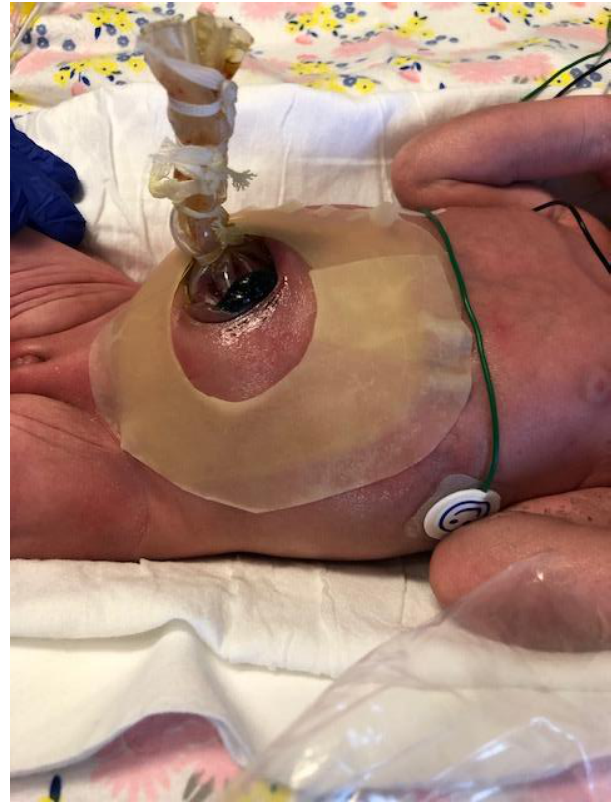
Figure 3. Staged reduction of gastroschisis. Shown is a picture with the bowel loops reduced into the abdomen using a silo. abdomen using a